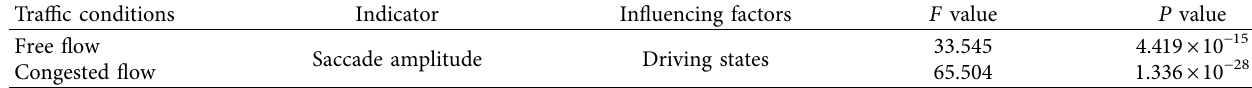
Table 5: One-way ANOVA of the infuence of driving state on saccade amplitude.